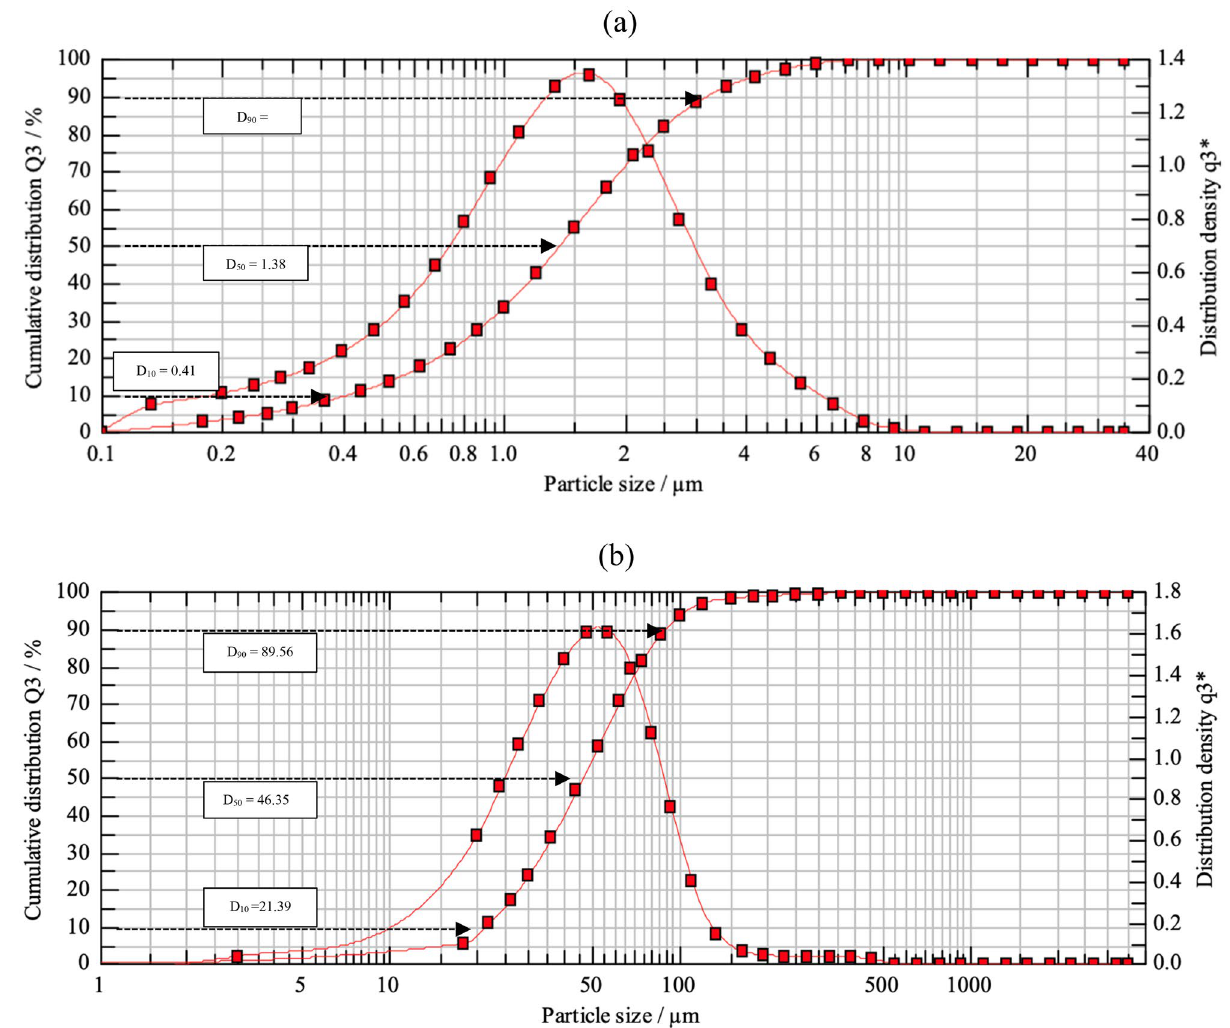
Figure 1. PDS for ( a ) Micromax and ( b ) perlite.